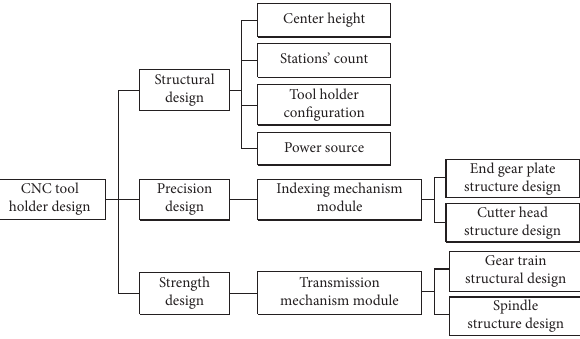
Figure 2: Design content diagram of the CNC tool holders. Table 2: Product performance requirements of the CNC tool